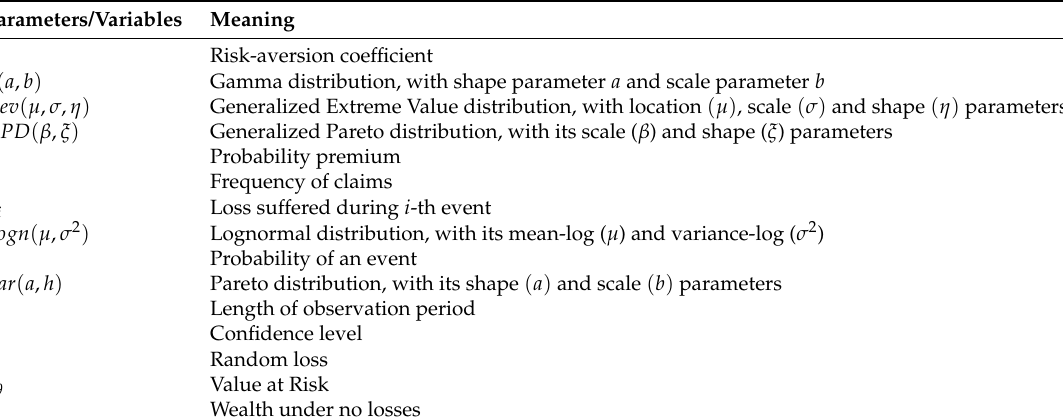
Table 1. Variables and parameters